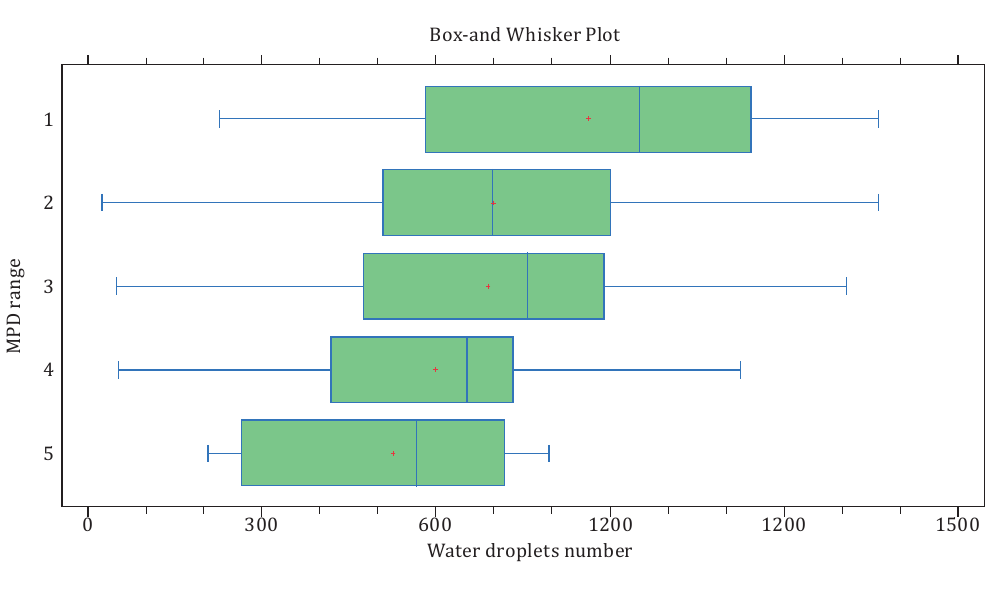
Box-and Whisker